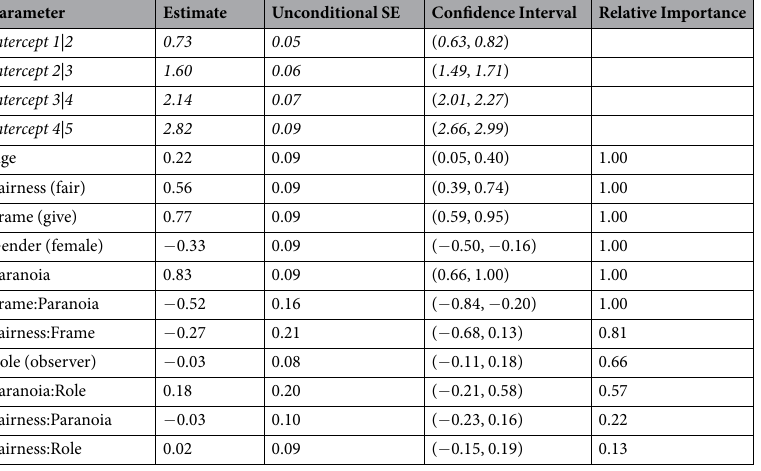
Table 1. Factors affecting attribution of harmful intent. Model averaged estimates, unconditional standard errors, confidence intervals and relative importance for the terms included in the top model set (Table S1). The response term for the model was a five-level, ordered categorical variable, indicating the extent to which participants attributed harmful intent to dictators. For categorical variables, reference levels are shown in parentheses. Input variables were scaled so estimates can be considered on the same